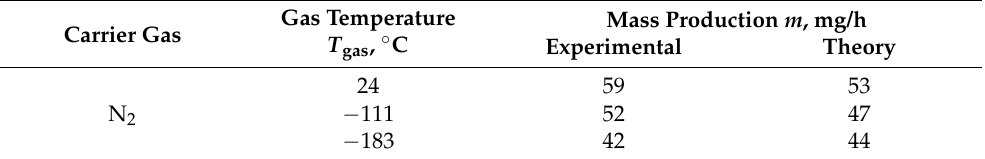
Table 3. Mass production of the synthesis of Au nanoparticles depending on the temperature of the carrier gas (nitrogen).